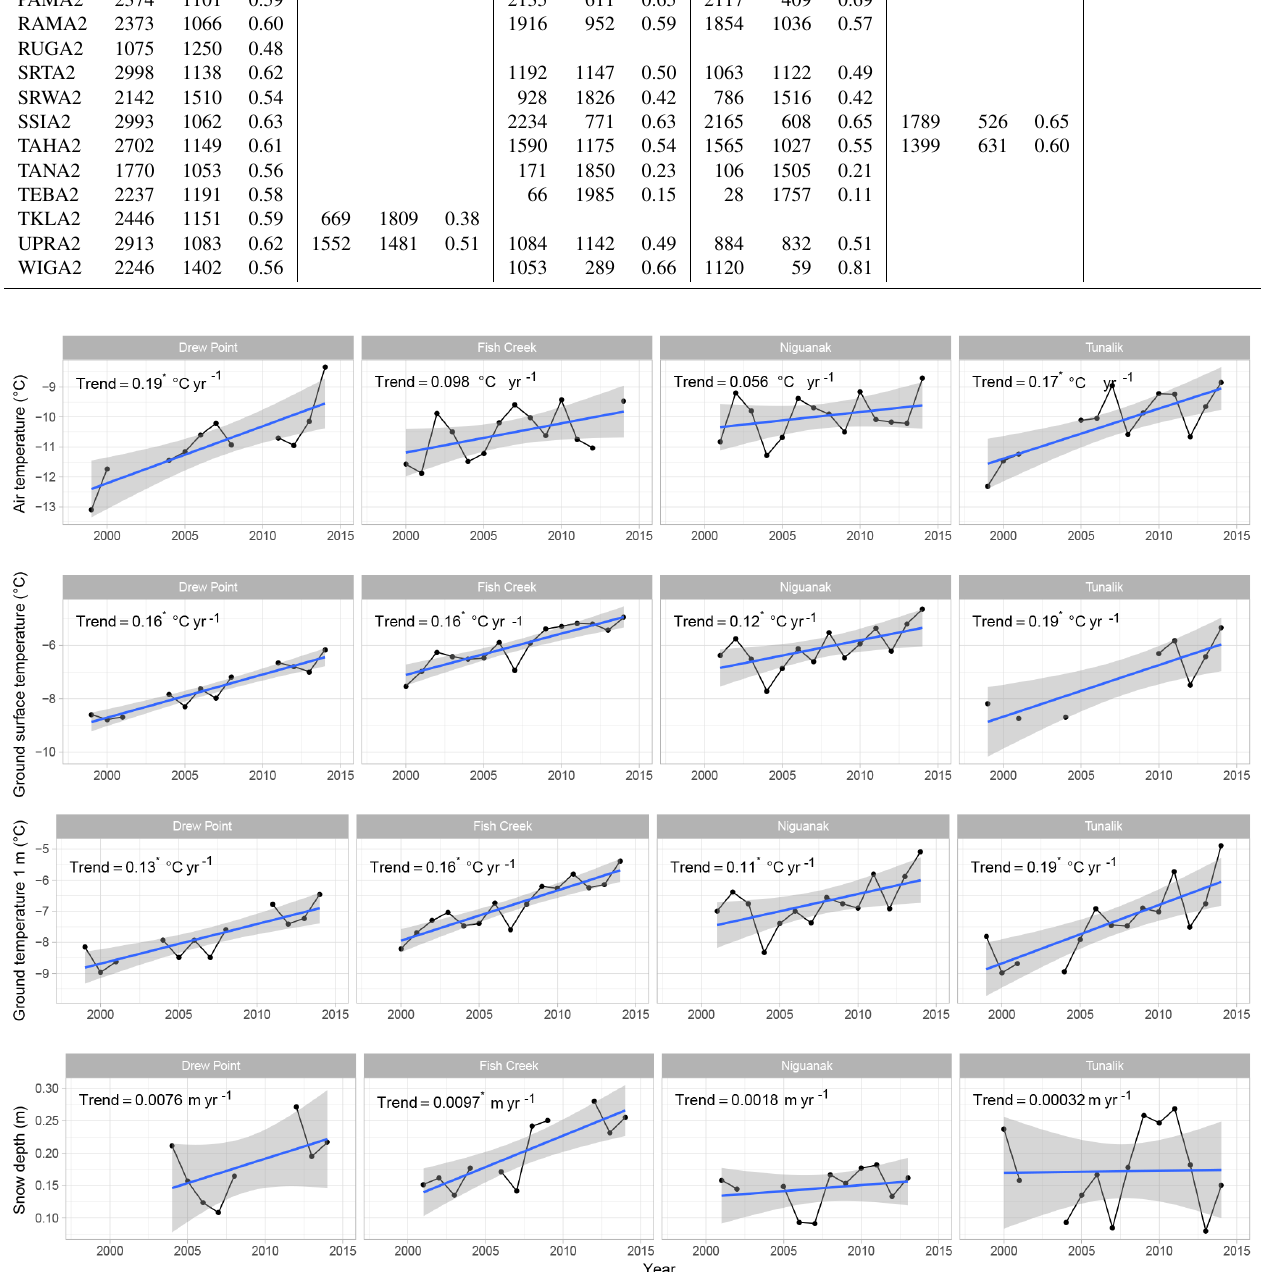
Figure 7. Examples of time series of mean-annual air, ground surface, ground temperature at 1m below ground surface, and snow depth. The black line shows the data time series, while the blue line is the estimated linear trend. Shading shows the standard error of the linear regression estimates. An asterisk indicates that the trend has a p value < 0 .